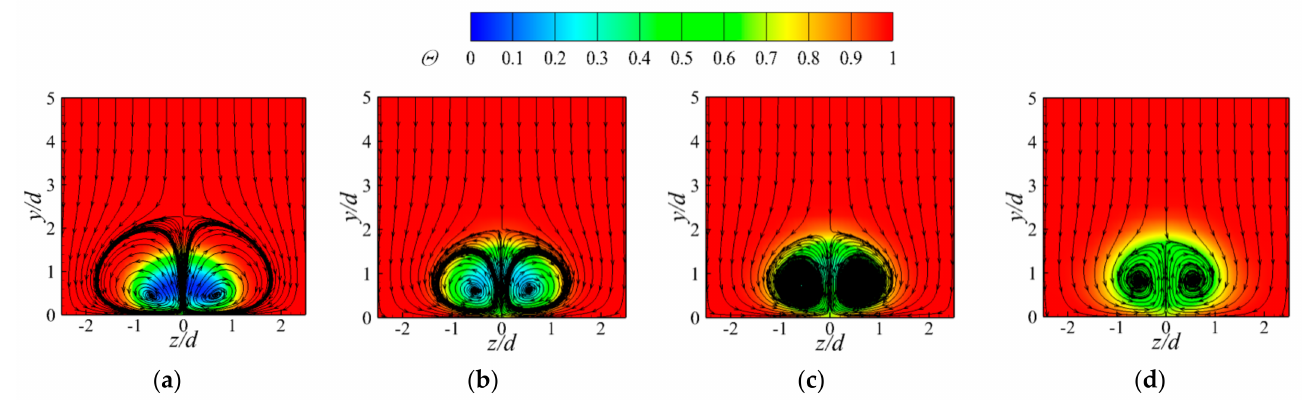
Figure 9. Dimensionless temperature contours and streamlines in downstream normal sections on the pressure side for cylindrical holes under M = 1.5. ( a ) s / d = 3, ( b ) s / d = 6, ( c ) s / d = 9, ( d ) s / d =